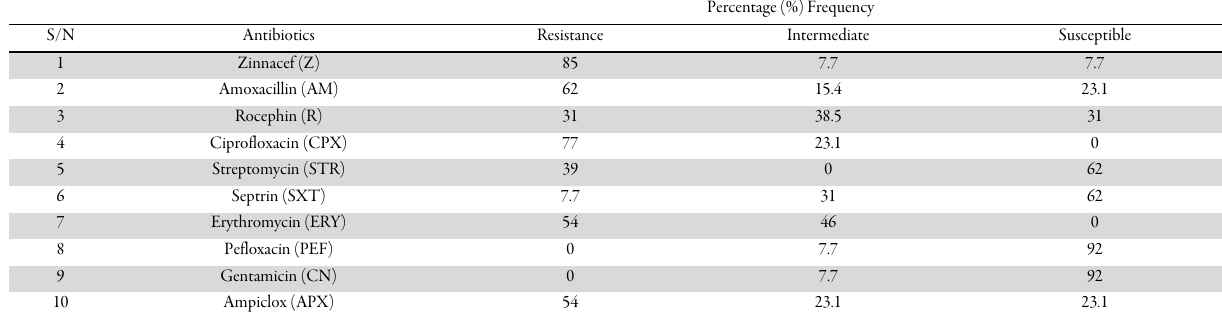
Table 3a. Percentage frequency of antibiotic susceptibility pattern for gram positive bacterial isolates